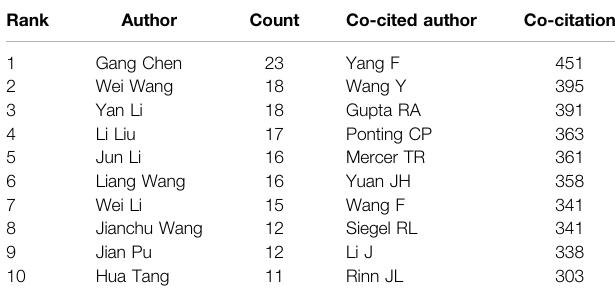
TABLE 3 | The top 10 authors and co-cited authors that published articles on the roles of lncRNAs in HCC development